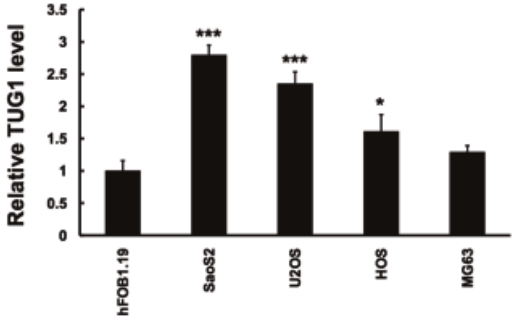
Figure 1: LncRNA TUG1 is upregulated in osteosarcoma cell line. QRT-PCR analysis performed to detect expression of LncRNA TUG1 expression in human normal osteoblastic cell line hFOB1.19 and human osteosarcoma cell lines. LncRNA TUG1 expression levels were calculated by the 2 −ΔCT method and normalized to GAPDH. ΔCt is the difference in Ct values between LncRNA and GAPDH . The plot shows the TUG1 expression was elevated.